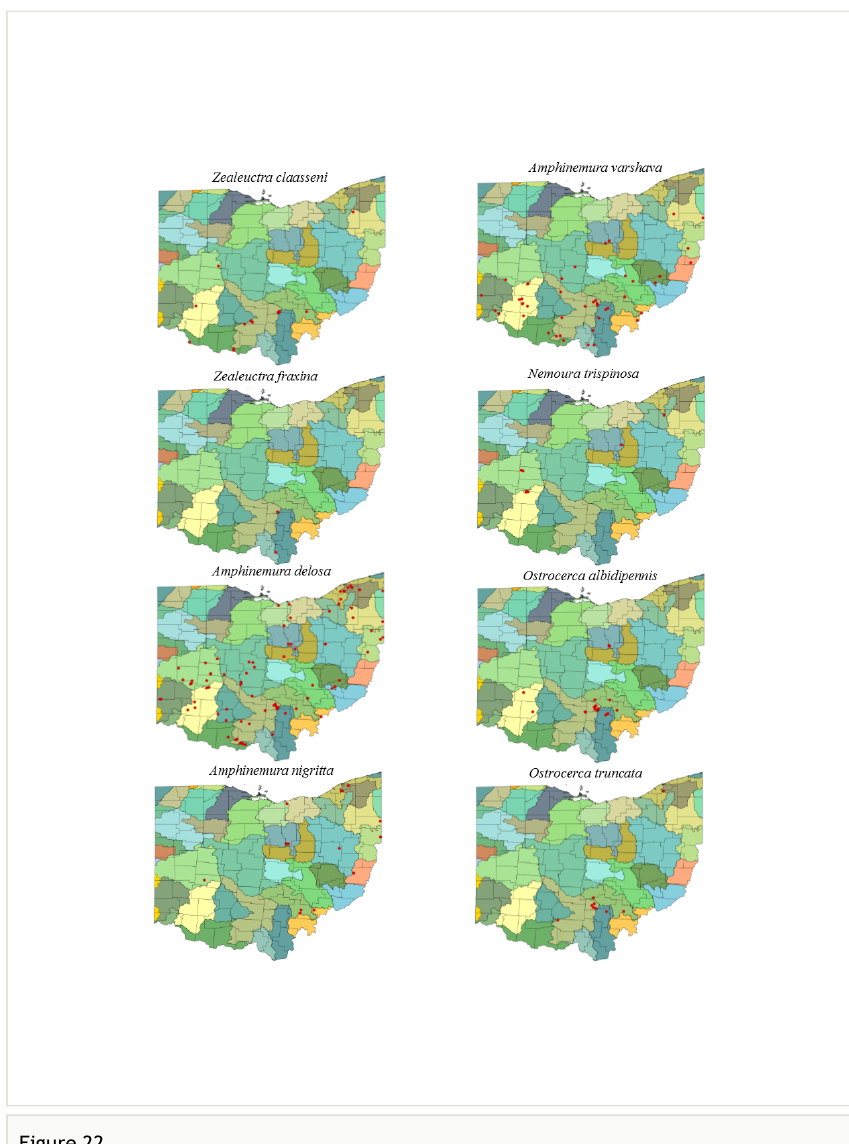
Figure 22. Distribution of Leuctridae and Nemouridae in